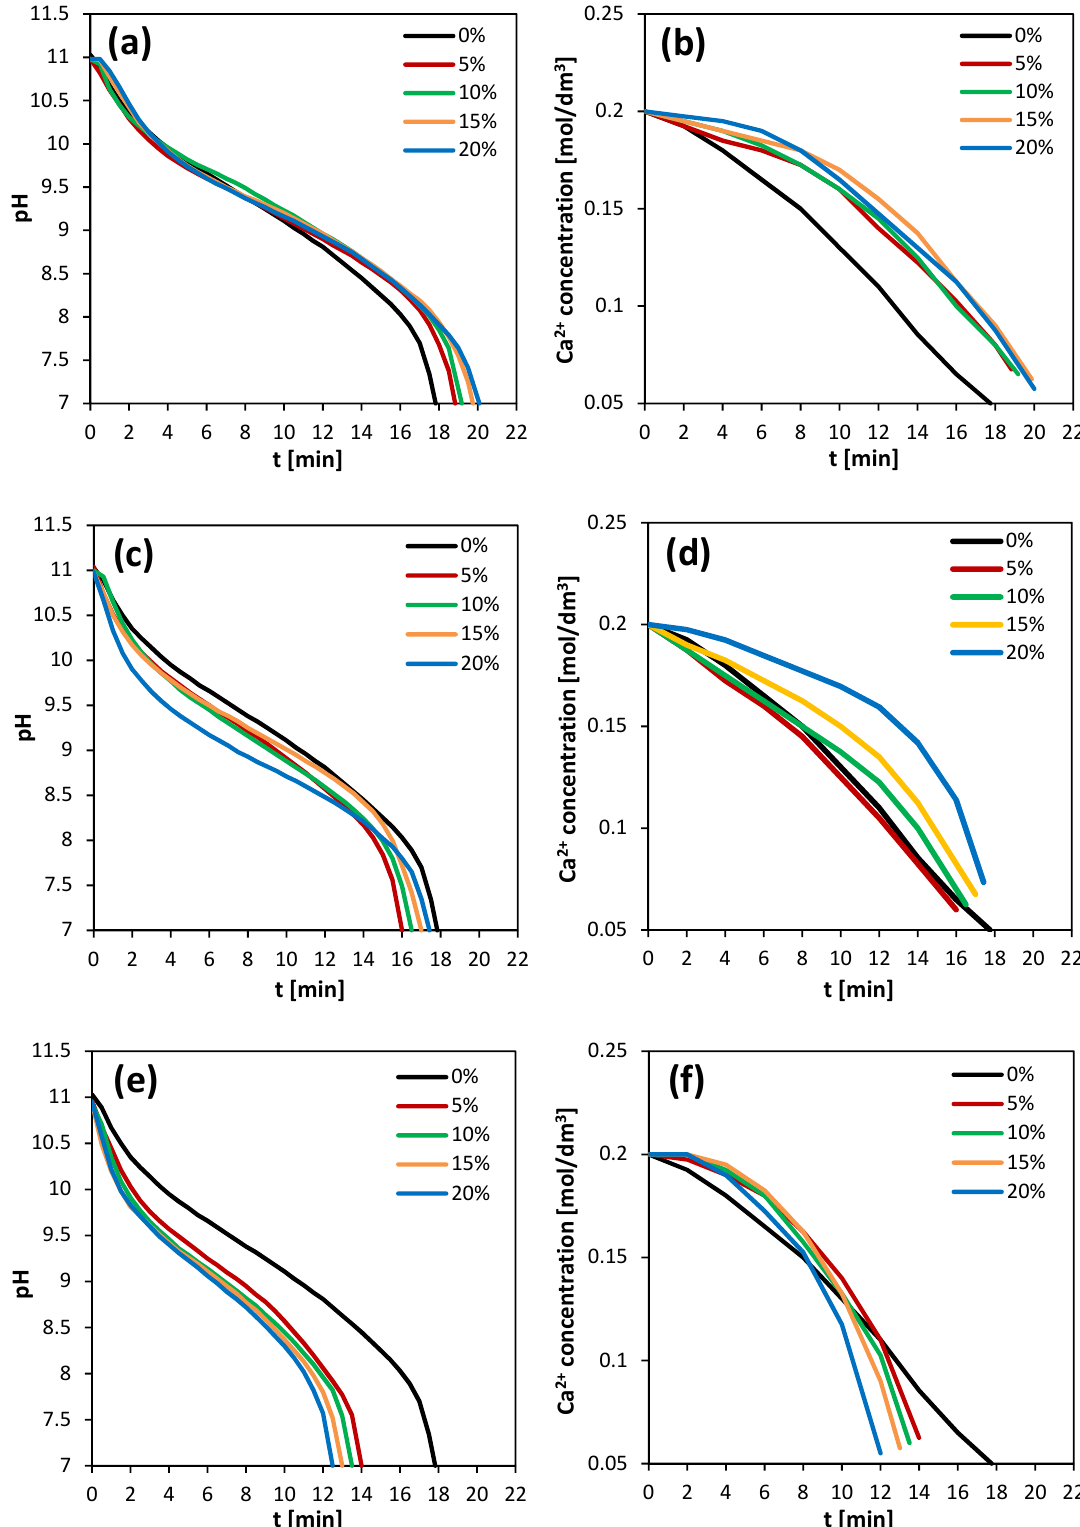
Figure 1. pH and Ca2 + concentration curves versus time for DMSO ( a , b ), methanol ( c , d ) and Figure 1. pH and Ca 2+ concentration curves versus time for DMSO ( a,b ), methanol ( c,d ) and isopropanol ( e , f ) depending on the solvent isopropanol ( e,f ) depending on the solvent concentration.